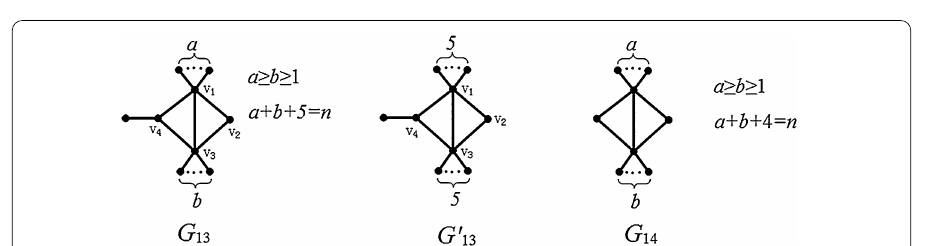
Figure 12 Some bicyclic graphs with θ (2,3,3) as their